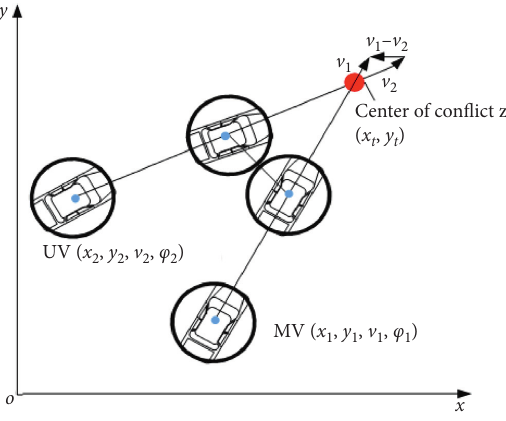
Center of conflict zone ( x , y ) t t